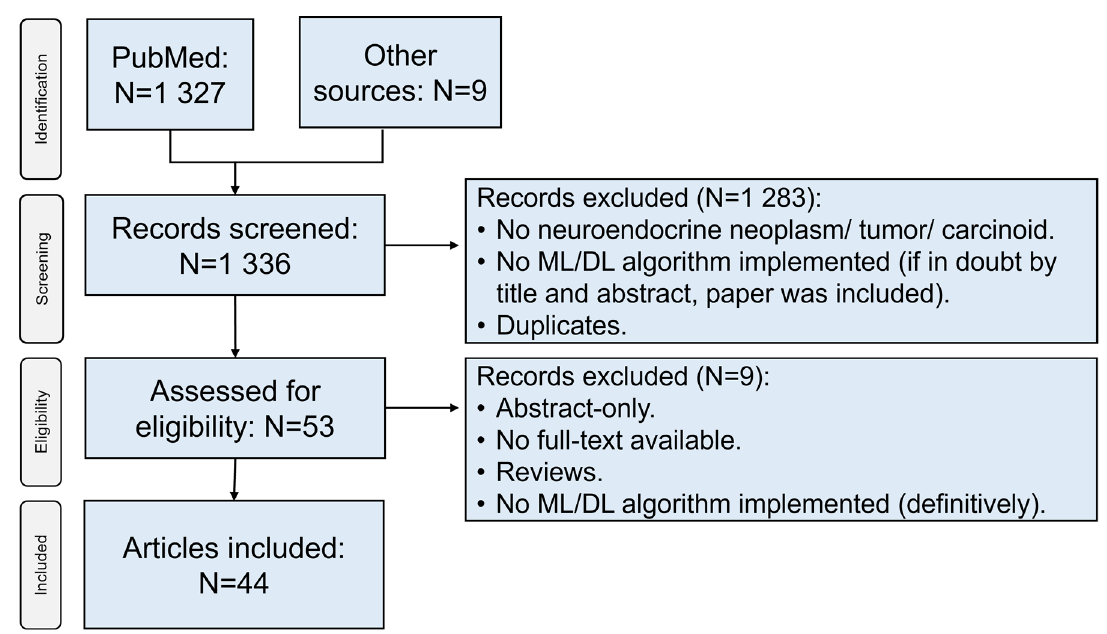
Figure 1. Flowchart depicting the selection process of sources of evidence. ML: machine learning; DL: deep learning.